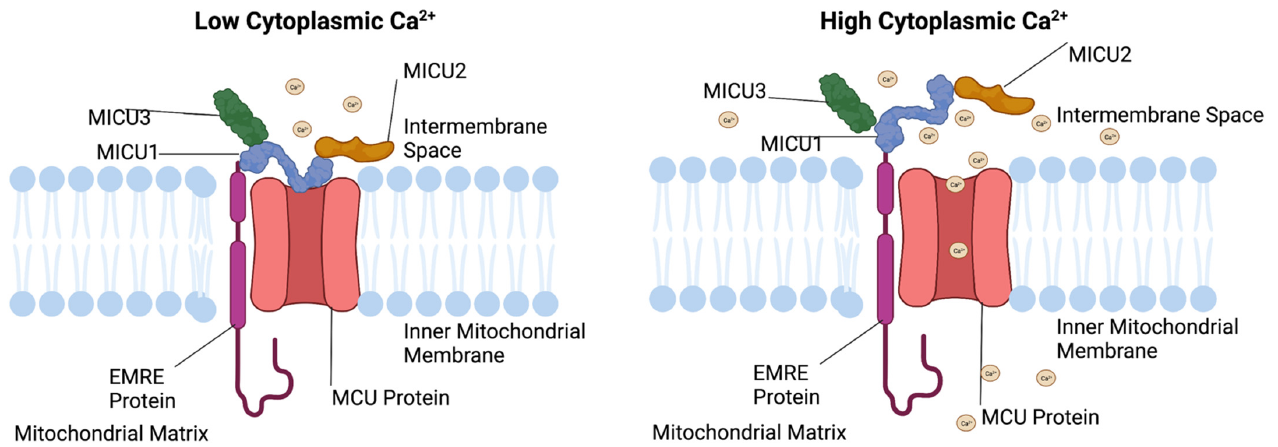
Figure 2. Mitochondrial Calcium Uniporter Complex under low and high cytosolic Ca 2+ conditions. Under low cytosolic Ca 2+ conditions the MCU is found in a closed state that impedes mitochondrial Ca 2+ entry. Under elevated cytosolic Ca 2+ conditions the MCU complex in the inner mitochondrial membrane is opened through Ca 2+ binding, thus resulting in mitochondrial Ca 2+ entry. MCU-Mito-